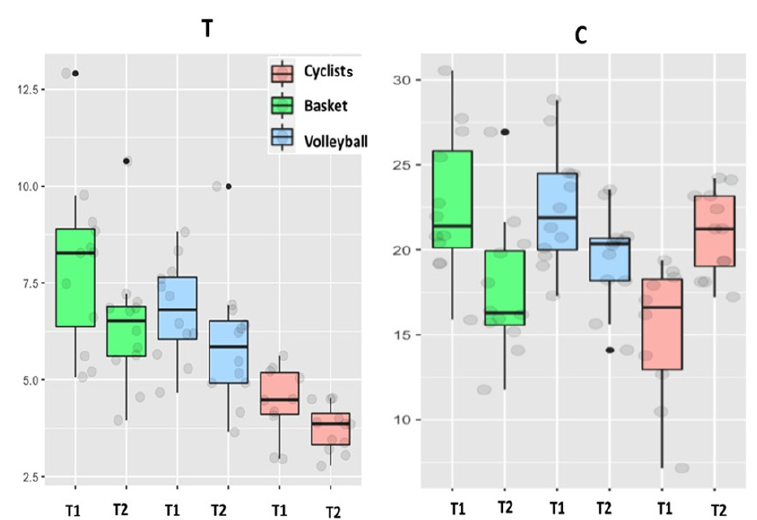
Figure 5. Testosterone (T) (ng/mL) and cortisol (C) ( µ g/dL) levels in cyclists, basketball and volleyball players at the end of T1 and T2.